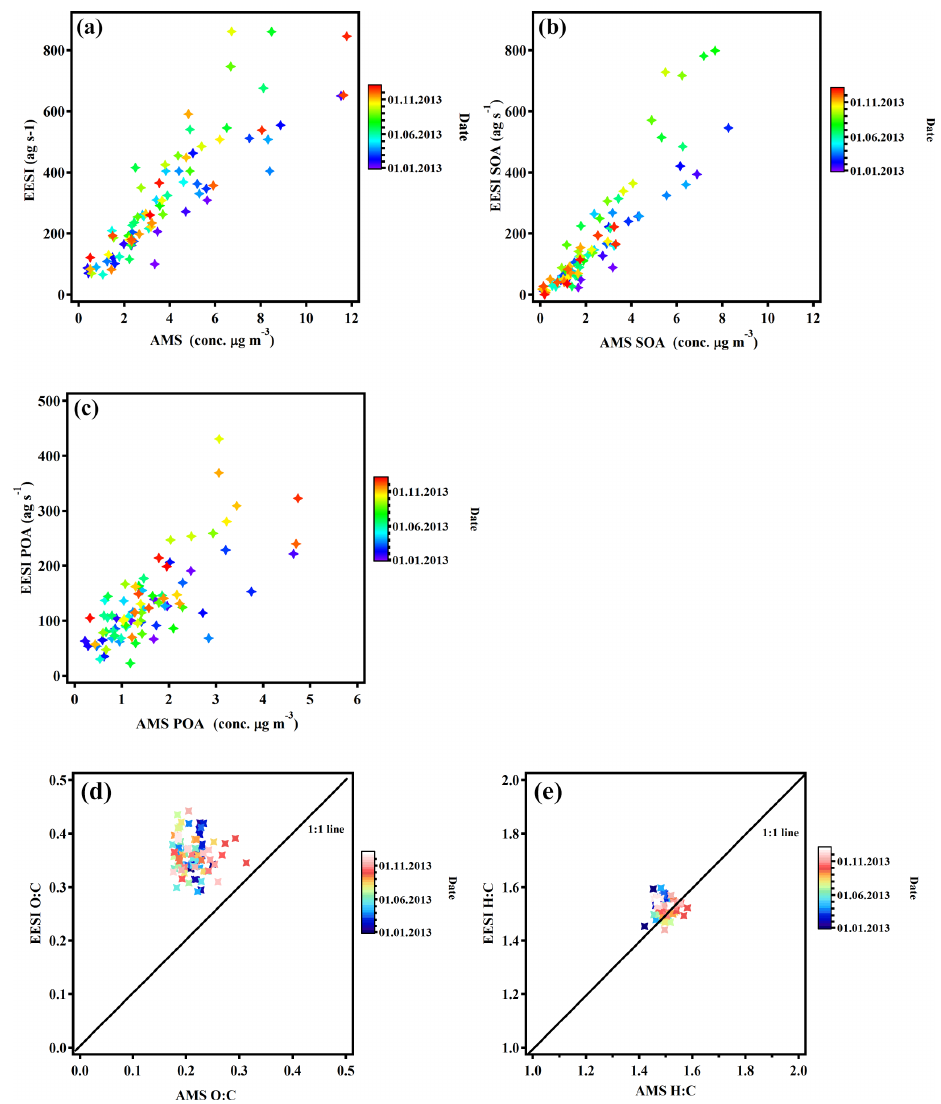
Figure 9. Comparison of EESI-TOF and AMS: total EESI-TOF mass flux (ags − 1 ) as a function of AMS OA, points are colored by date (a) ; total EESI-TOF SOA mass flux (ags − 1 ) as a function of AMS SOA, points are colored by date (b) ; total EESI-TOF POA mass flux (ags − 1 ) as a function of AMS POA, points are colored by date (c) ; the EESI-TOF and AMS comparison in terms of O : C (d) and H : C (e) , points are colored by